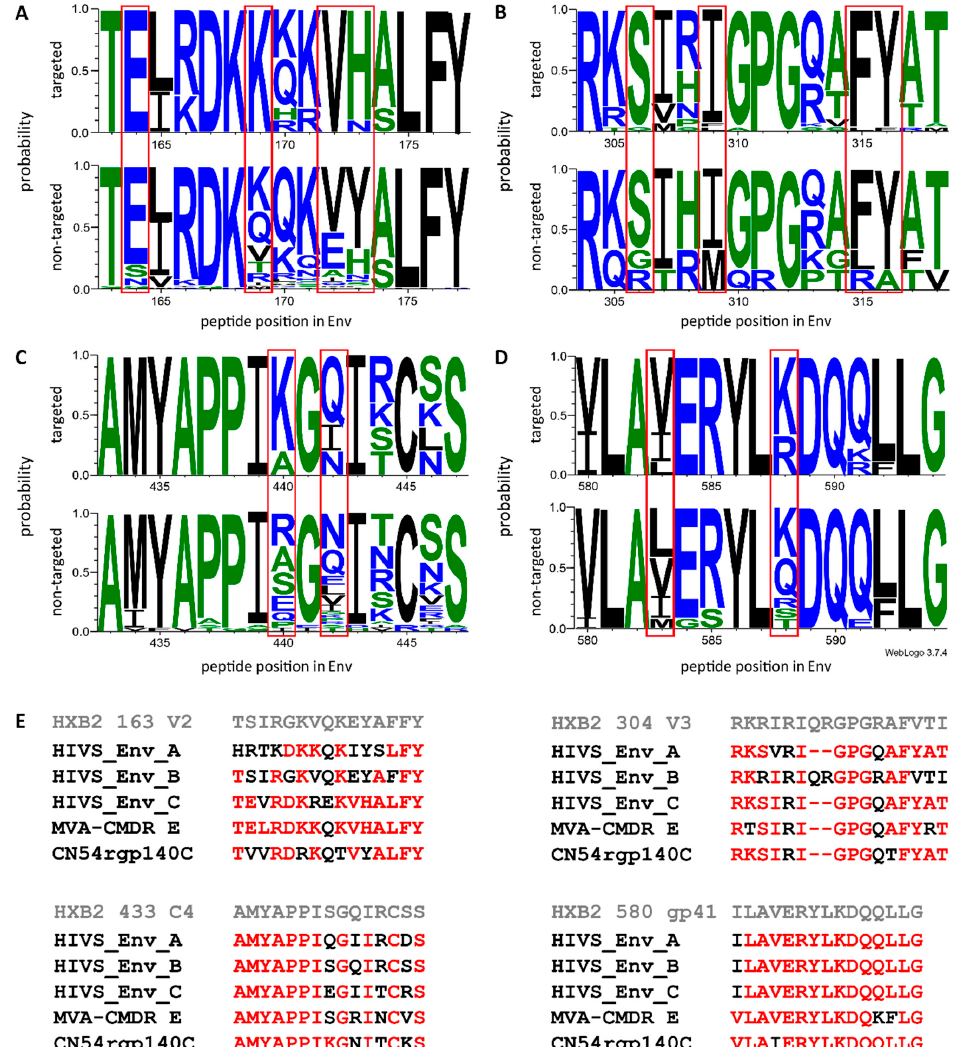
Figure 3. Preferred amino acid recognition at distinct Env positions in vaccinees. Sequence